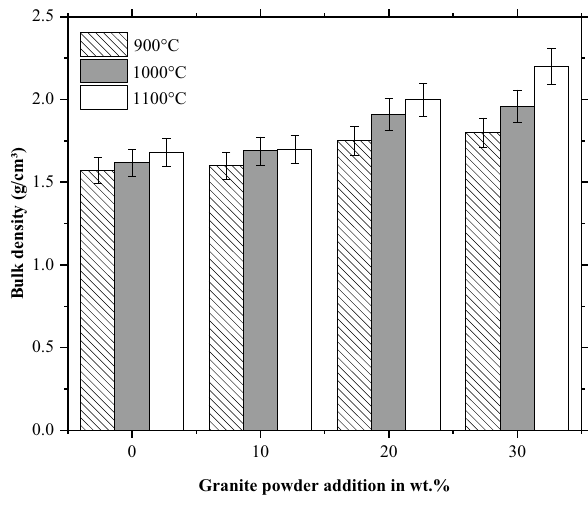
Fig. 5 Apparent porosity of fired clay bricks fired at 900, 1000 and 1100 °C Fig. 6 Bulk density of fired clay bricks fired at 900, 1000 and 1100